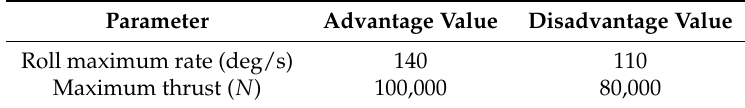
Table 3. The aircraft performance parameters setting.